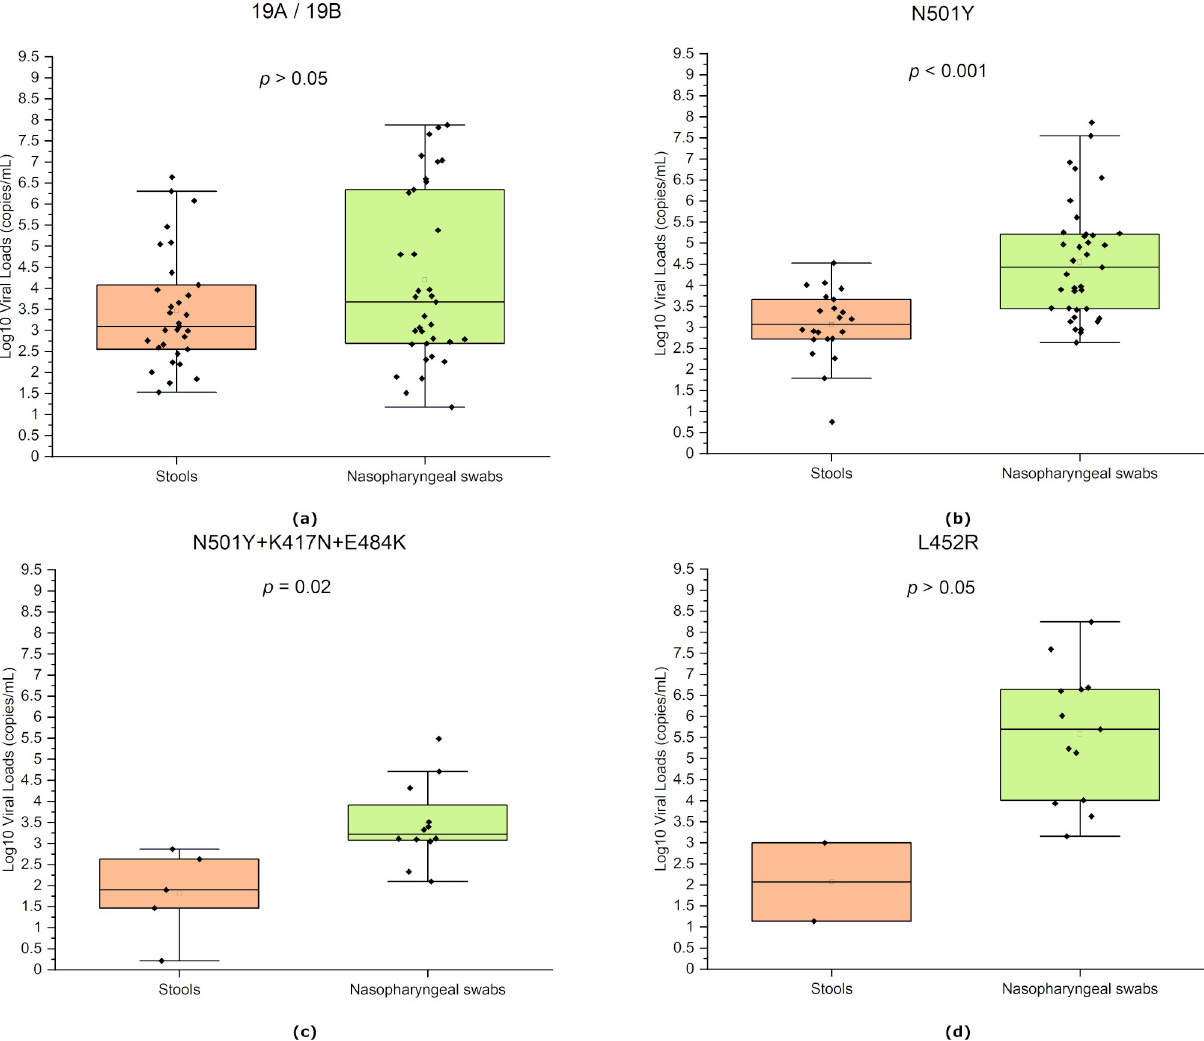
Fig 4. Comparing viral loads in stools and nasopharyngeal swabs of patients infected by different SARS-CoV-2 variants. (a) negative for S protein mutations (b) N501Y mutation, (c) N501Y+K417N+E484K mutations, and (d) L452R mutation. The graph presents the median and the minimal to the maximal range of viral load in log10 copies/mL. The significance of the pairwise two-sided t-tests is indicated on